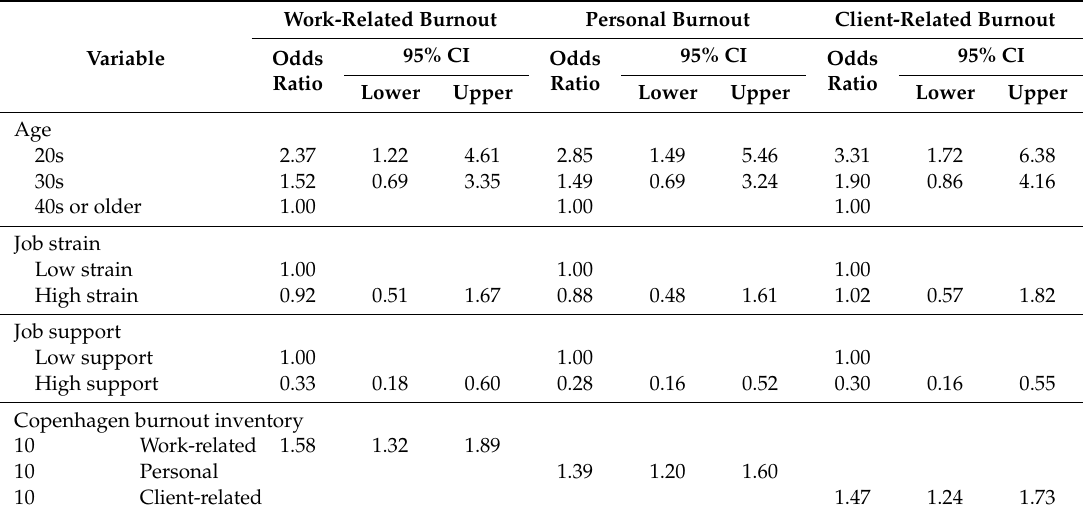
Table 4. Stepwise multivariable regression model for factors associated with “intention to leave” adjusting for each domain of the Copenhagen Burnout